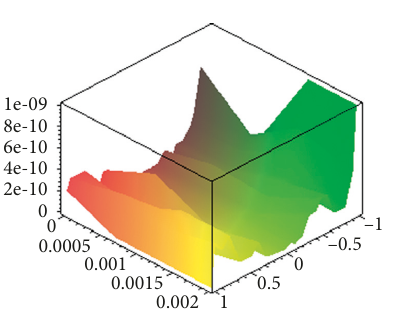
Figure 4: The error of logarithmic kernel at. k